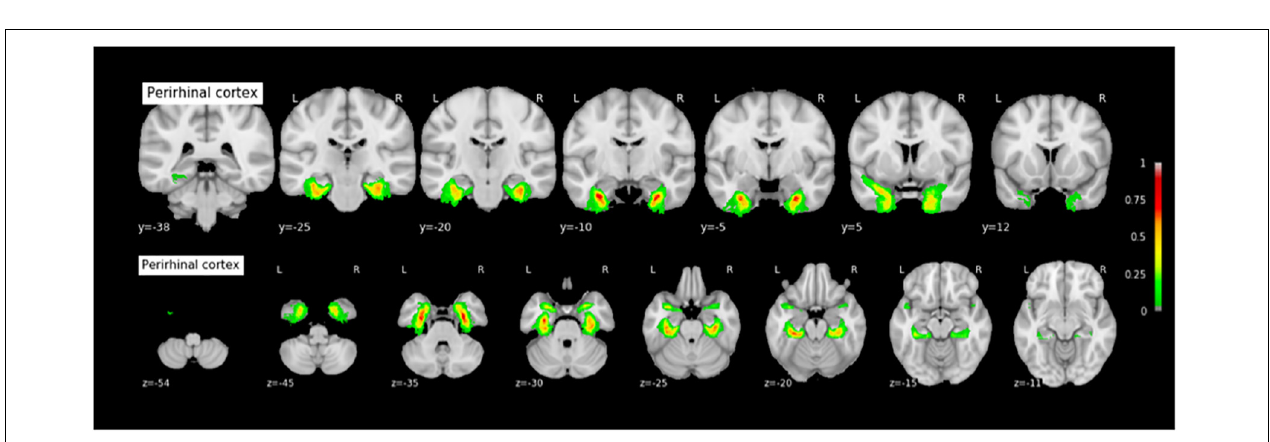
FIGURE 8 | Probabilistic map of the entorhinal cortex (ERC). The maps are normalized into the MNI stereotaxic space. Coordinates are indicated on each slice.